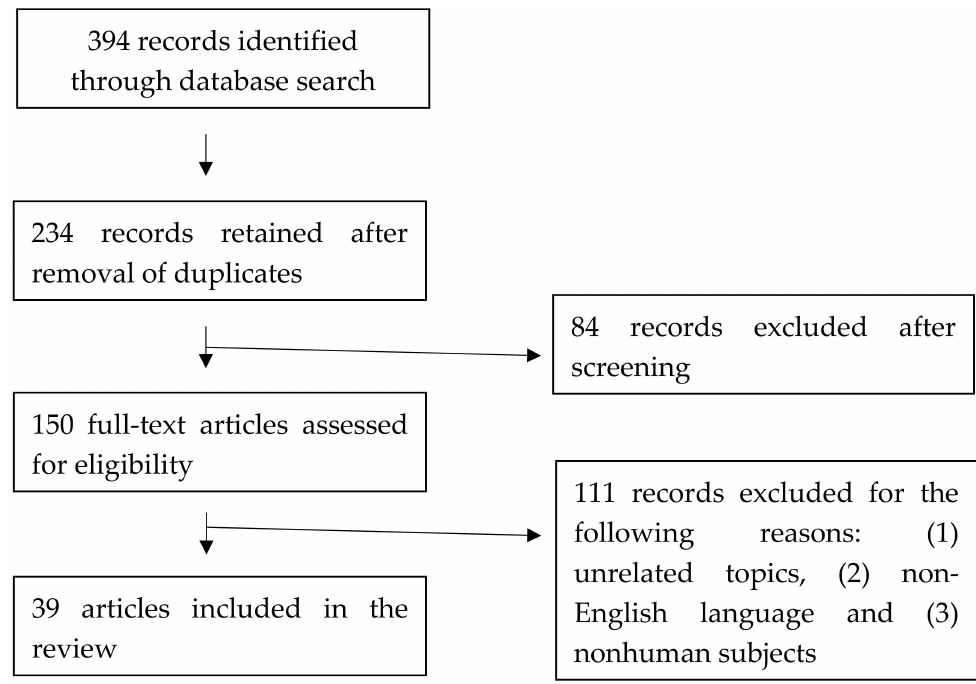
Figure 1. Summary of review